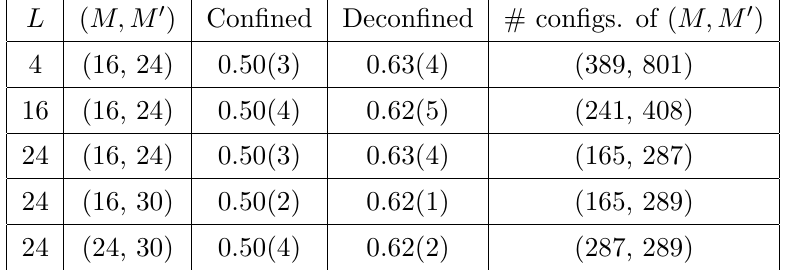
Table 1. The variances in the Gaussian matrix model. d = 2 , N = 32 at T = T c = 1 number of lattice sites is L . The total number of x is obtained by # x = 32 2 × 2 × L × ( # configs. ) .